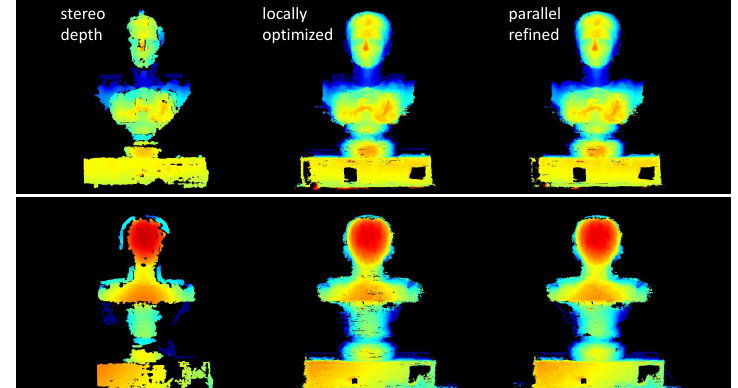
Figure 20. Evolution of the depth maps for the sampled front ( top ) and back ( bottom ) views. From left to right are raw depth maps from static stereo, locally optimized and parallel refined results. We can see that after local optimization process raw stereo depths are well propagated and optimized (in particular for structure-rich regions), and artifacts are filtered through geometric consistency and the NCC-based confidence check. The subsequent parallel refinement effectively suppresses noise inherited from the local optimization while preserving and sharpening fine structures of the object.